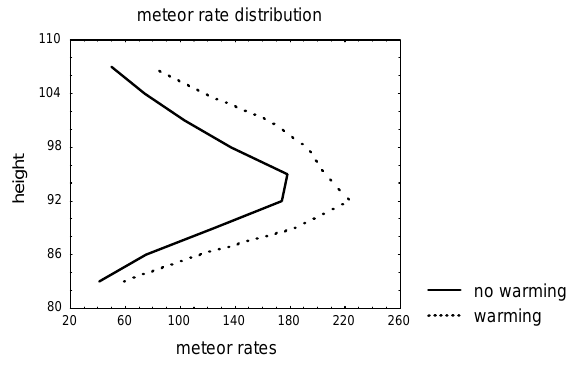
Fig. 14. Vertical profiles of the meteor rates over Kazan during the stratospheric warming in December 1998 and during a quiet period in the beginning of January 1999.